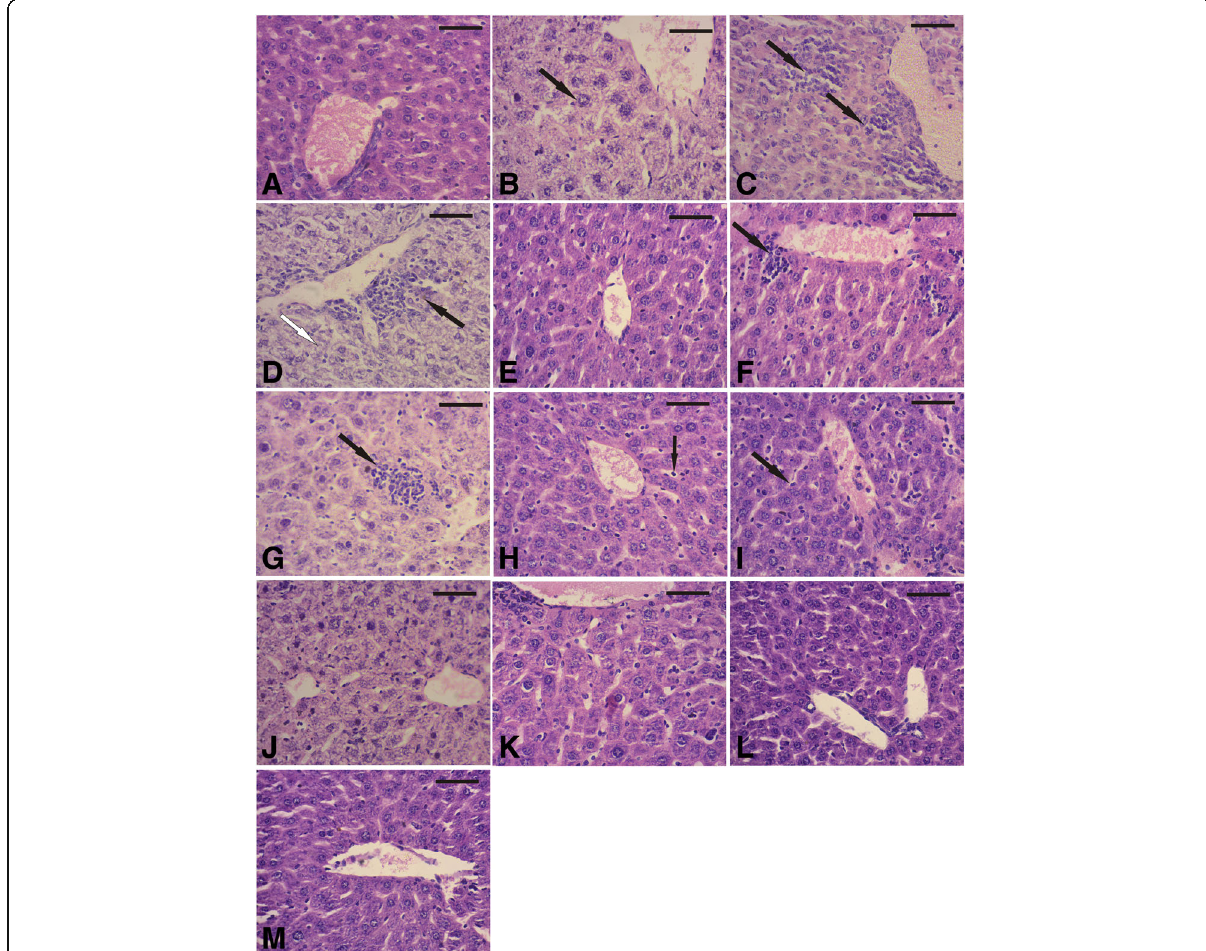
Fig. 1 Photomicrographs of liver sections of the control group ( a ). Acrylamide-administrated groups 30, 45, 60 days ( b – d ) showing increased inflammatory infiltrated cells and necrosis of cells accompanied with pyknosis of cell nuclei as compared with the control group. Chips feeding groups at 45 and 60 days ( f , g ) showing increased inflammatory infiltrated cells and necrosis of cells with pyknosis of cell nuclei as compared to the chips feeding group at 30 days ( e ). Bee venom-treated ( h ) or BPF-treated ( i ) groups at 60 days showing the similar structure as observed in the control. Acrylamide-administrated groups treated with either bee venom ( j ) or BPF ( k ) showing improvement in the form of decreased inflammatory infiltrated cells. Chips feeding groups treated with either BV ( l ) or BPF ( m ) showing improvement in the histological architecture as compared with chips feeding groups. H&E stain scale bar 10 μ